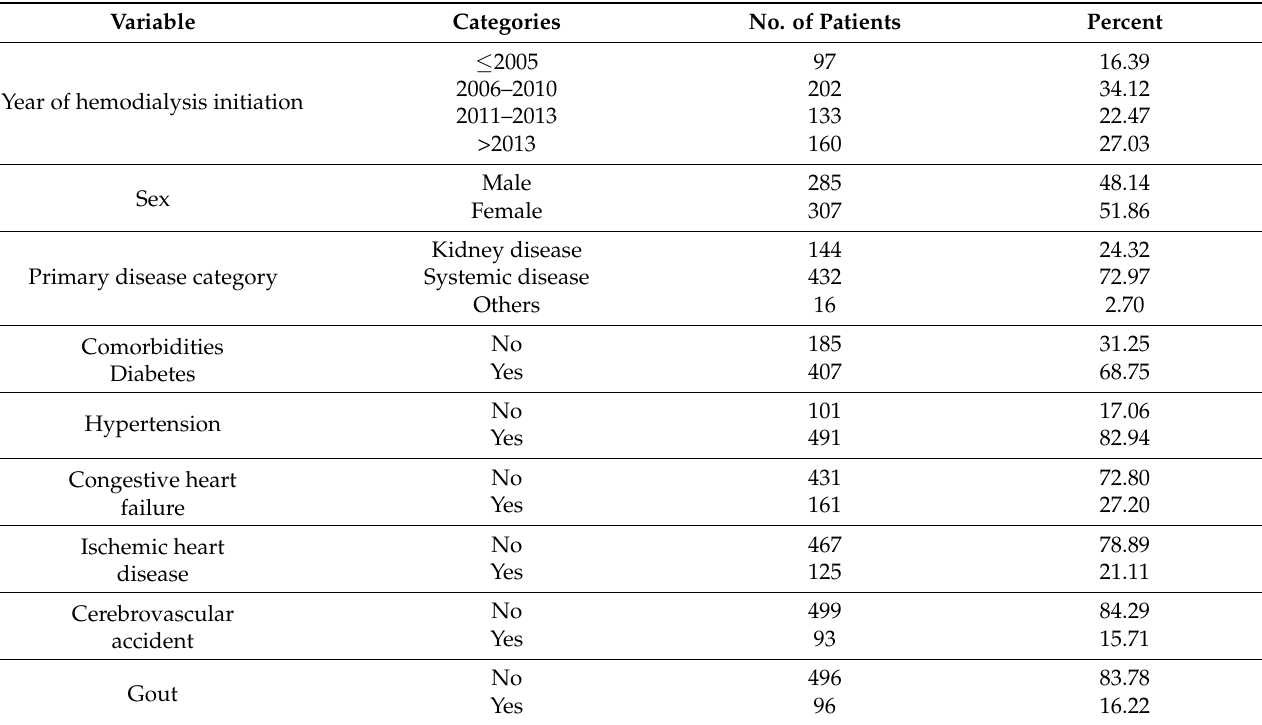
Table 1. Patient demographic characteristics.